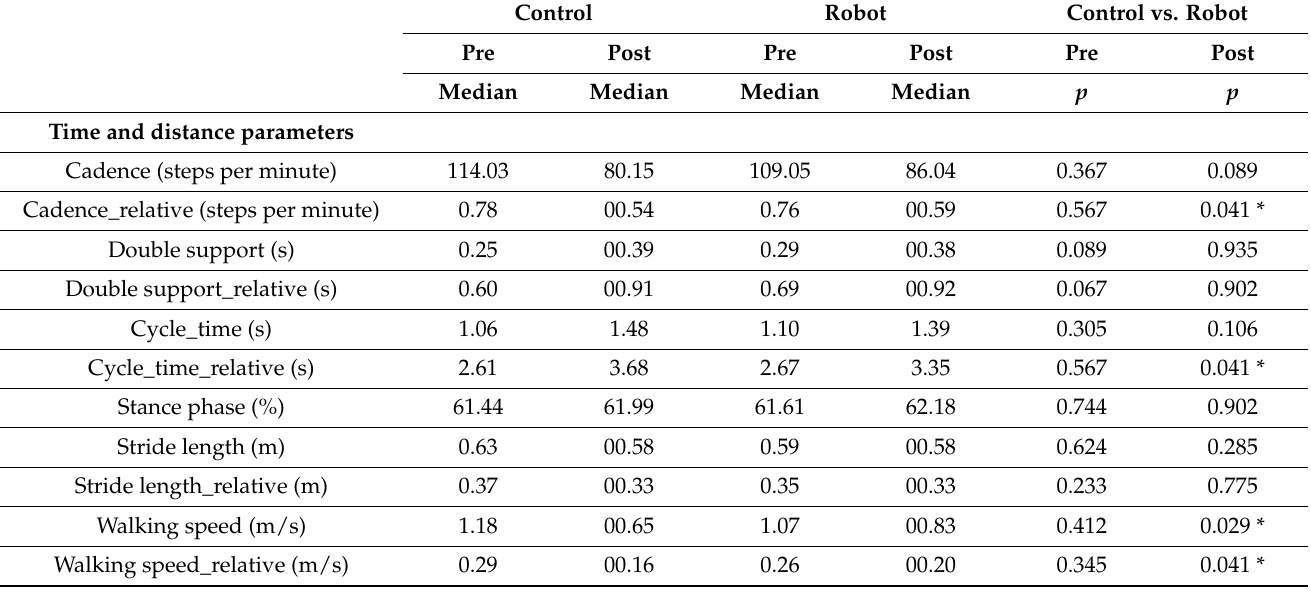
Table 2. Shows the time and distance parameters of the gait analysis. A p value of <0.05 was defined as showing a significant